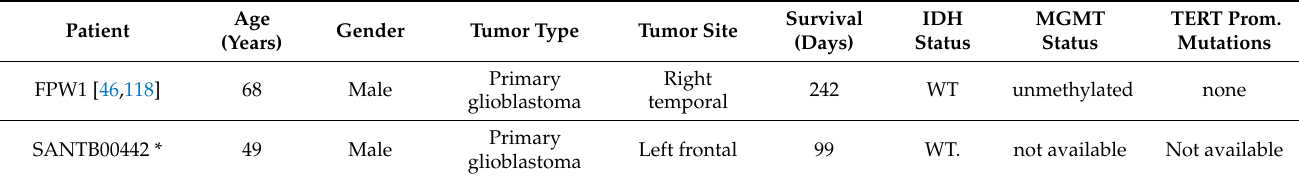
Table 2. Patient demographics corresponding to in vitro models used in this